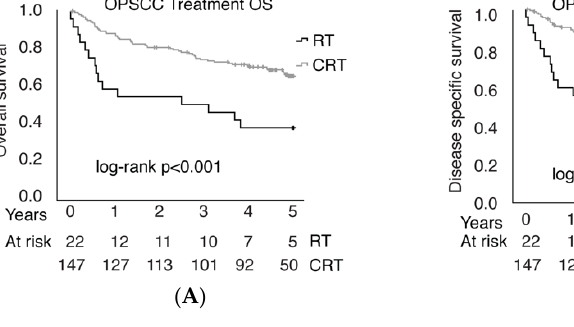
Figure 4. OPSCC overall survival (OS, A ), disease-specific survival (DSS, B ) and disease-free survival (DFS, C ) after radio- (RT) or chemoradiotherapy (CRT).